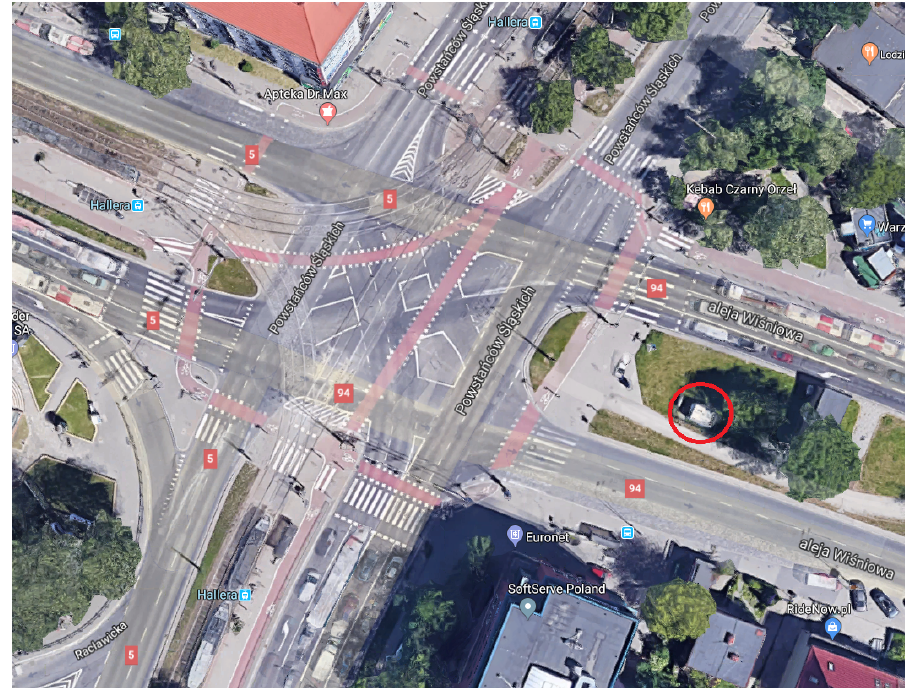
Figure 2. An aerial view of the area of interest. The red circle is the communication station. Table 2. Descriptive